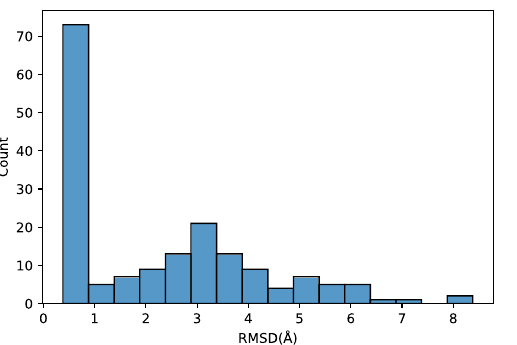
Figure 1. Distribution of minimum root mean square distance between trajectories and native